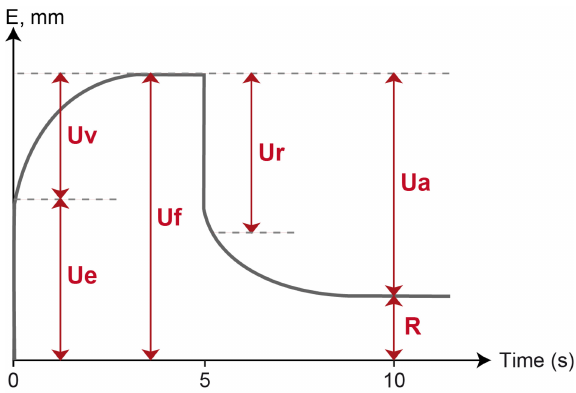
Figure 2. Example of the deformation curve with the indications of